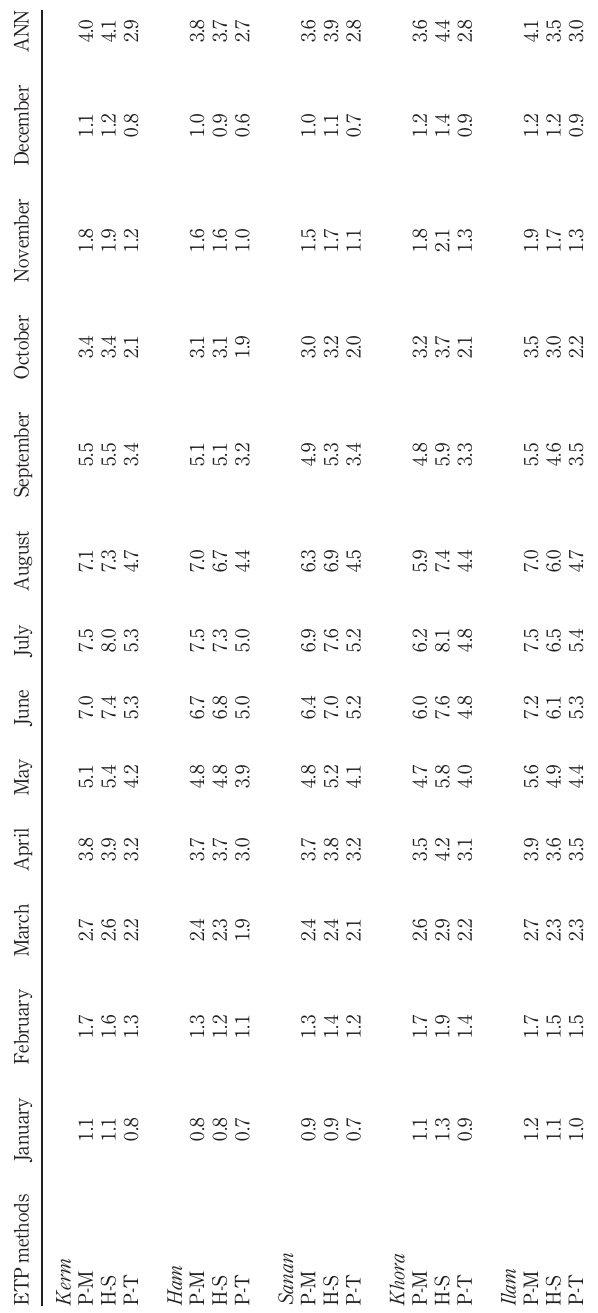
Table II. Calculated ETP mean by different methods in the observed period